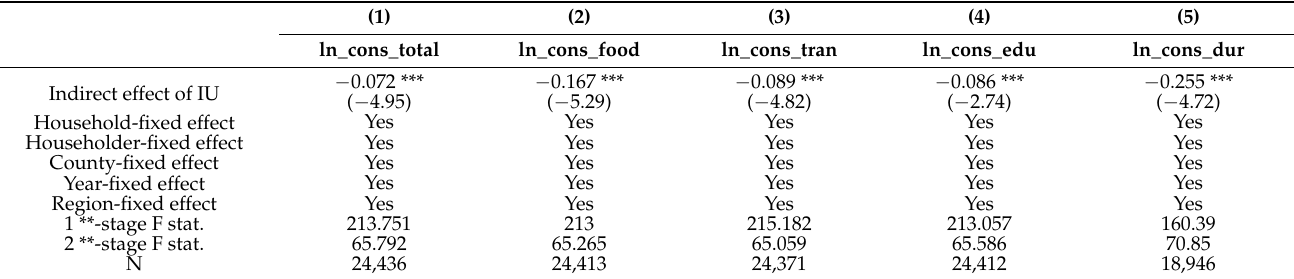
Table 7. Results of the anticipated effect: CMA model.